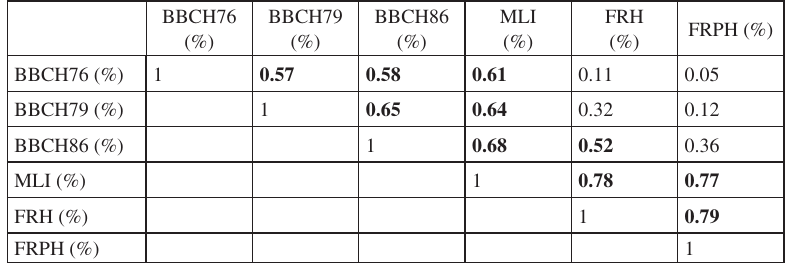
Table 2. Correlation coefficients between latent infection at different phenological stages and harvest and posthavest fruit rot caused by Monilinia spp. in sour cherry (Eperjeske 2013 and 2014) and peach (Siófok 2013 and 2014). Significant r values (P (cid:41) 0.05) are in